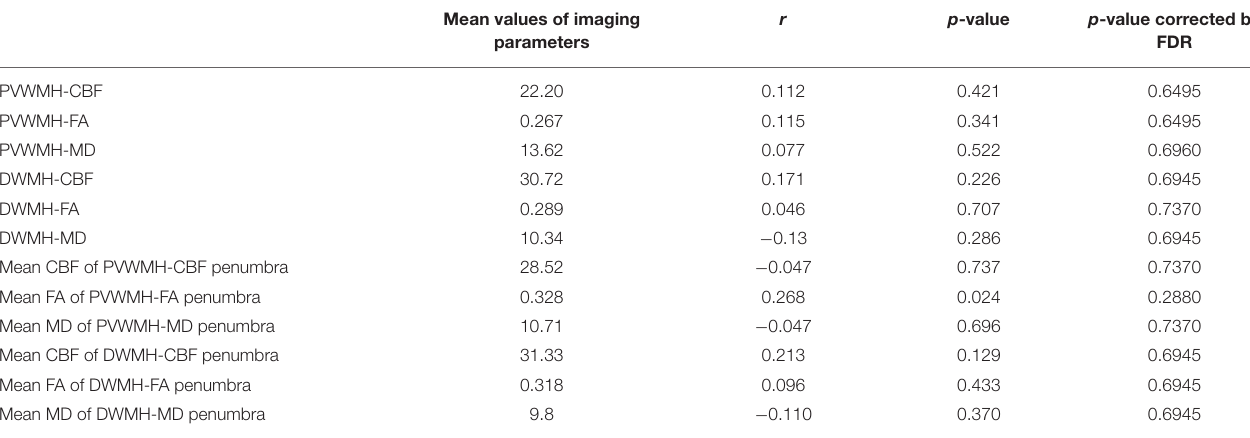
TABLE 4 | Relations between the mean FA, MD, and CBF values of PVWMH, DWMH, and their penumbras with composite z-scores of global cognition.